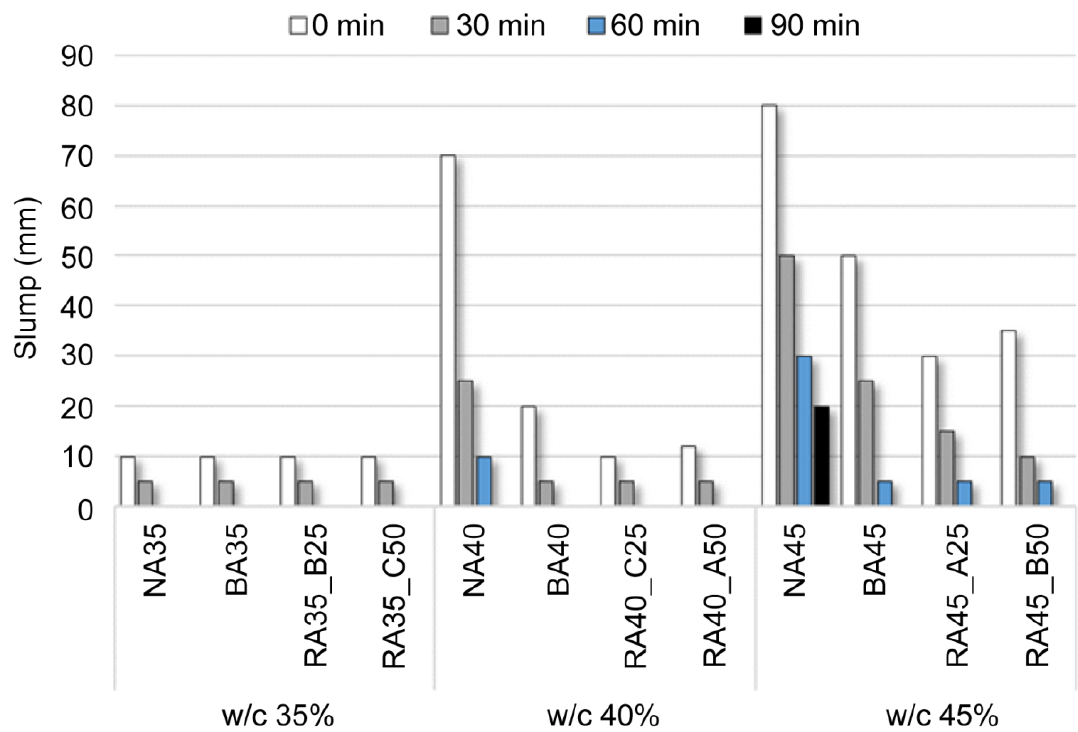
Figure 4. Slump of fresh concrete according to water–cement (w/c) ratio.